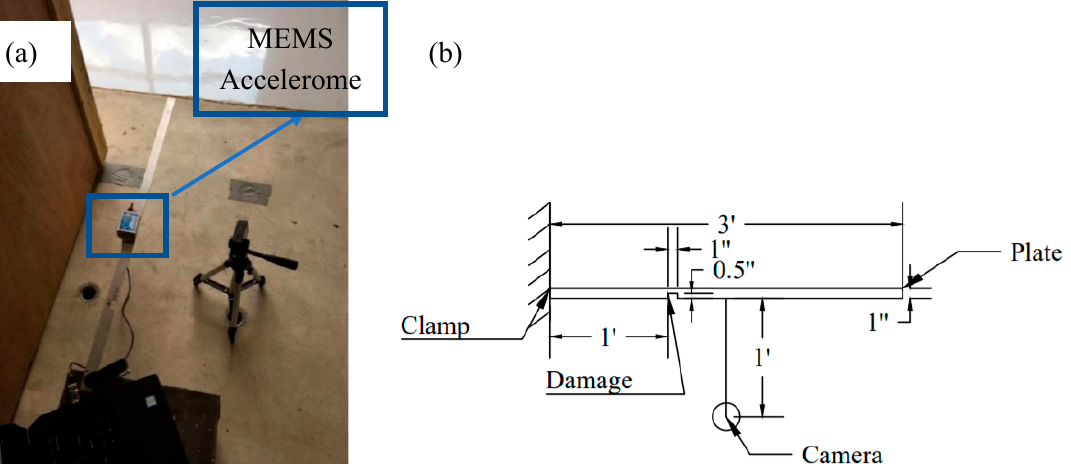
Figure 13. ( a ) Setup of the steel beam vibration test, ( b ) Schematic diagram of the experiment setup (1’ = 12’’ = 0.3048 m).